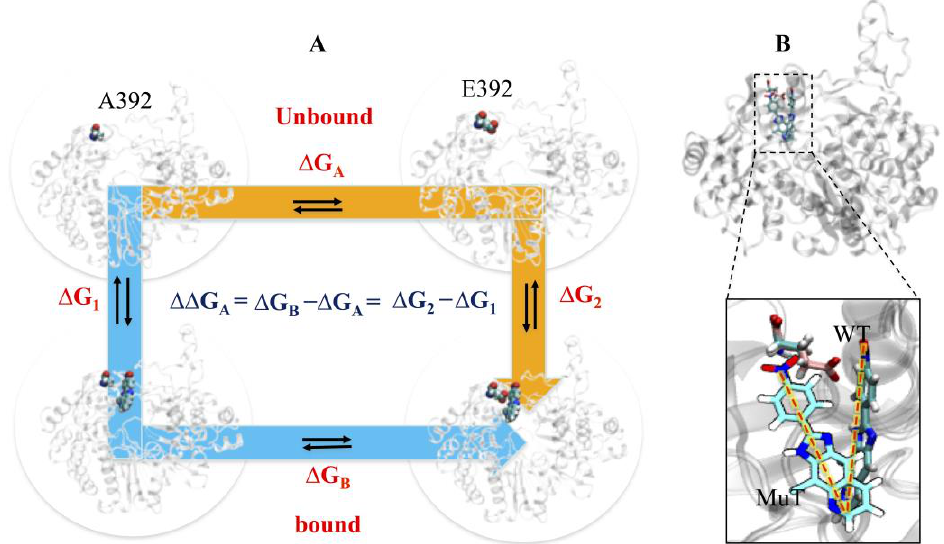
Figure 9. ( A ) Energy calculations of mutant systems via two routes, bound and unbound, respectively. ΔG A represents a change in energy between mutants (A392, E392) in the unbound state, and ΔG B represents a change in energy between mutants (A392, E392) when they are bound to the ligand. ΔG 1 represents a change in the energy of mutant A392 between bound and unbound ligand states, and ΔG 2 represents a change in mutant E392 between bound and unbound ligand states. ( B ) Change in the binding mode of 2h observed in the mutant state.